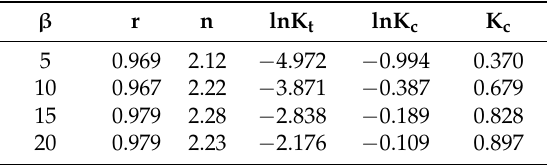
Table 1. Detailed data of crystallization kinetic